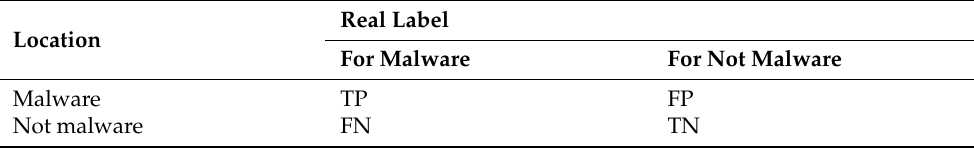
Table 2. Confusion